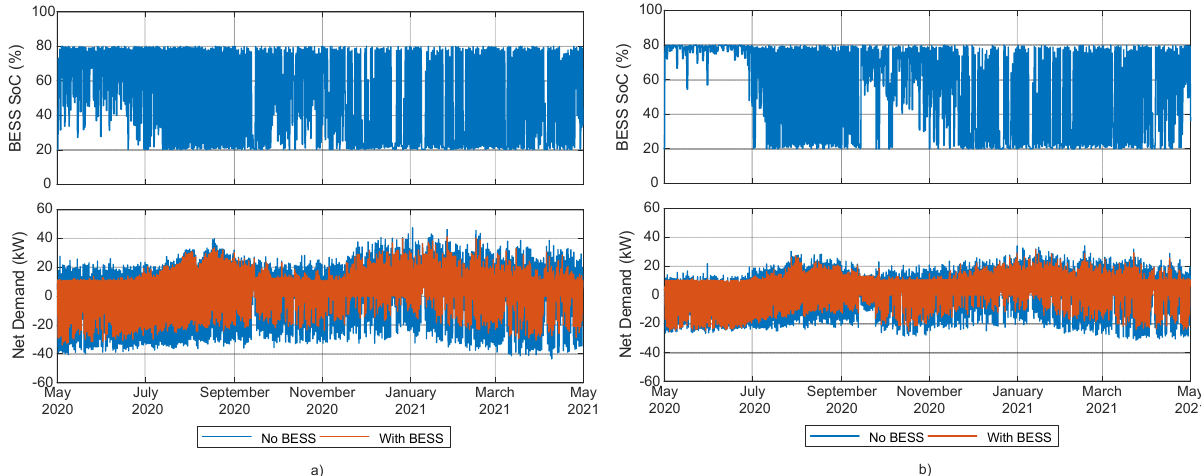
Figure 10. Net demand with and without storage and daily variations in the State of Charge. ( a ) EC2 with a 55 kWh BESS. ( b ) EC3 with a 31 kWh BESS.